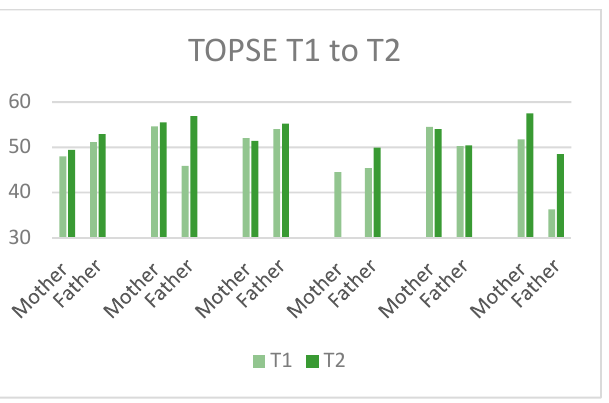
Figure 6. Ratings on the TOPSE each family at T1 and T2. Higher scores imply higher parenting self-efficacy.